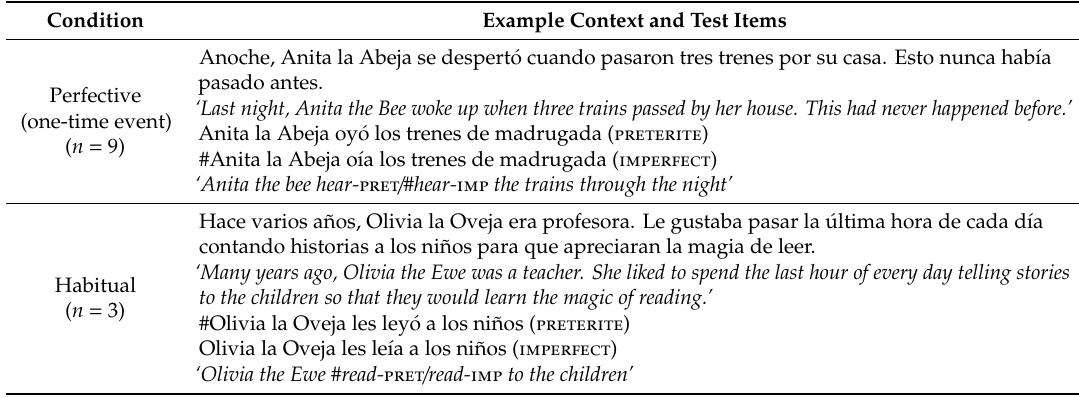
Table 2. Example contexts and test items for each